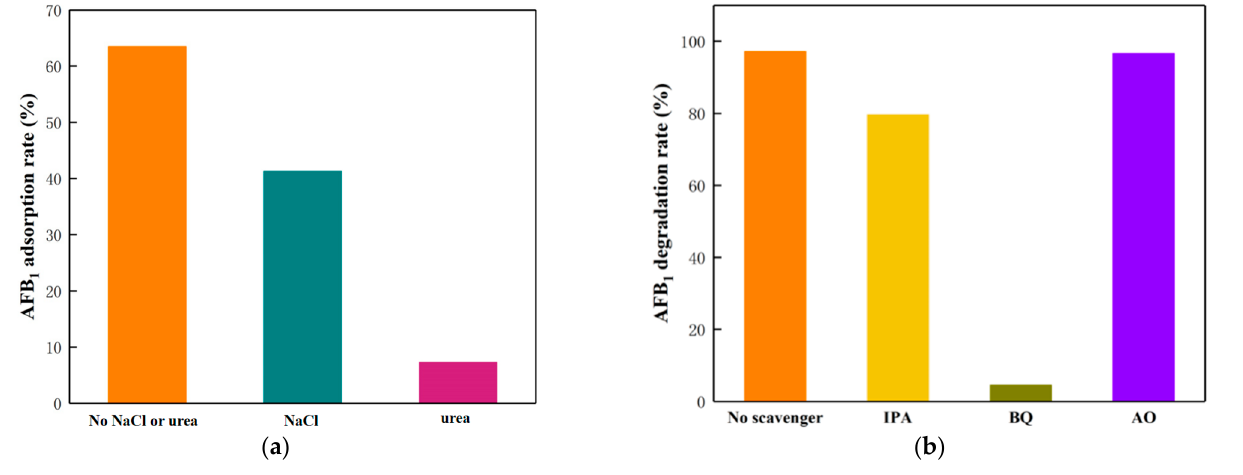
Figure 11. ( a ) Adsorption activities of modified PCL electrospun membranes in the presence of NaCl/urea (or not). ( b ) Photocatalytic activities of g-C 3 N 4 /CQDs composites for the degradation of AFB 1 in the presence of different scavengers.